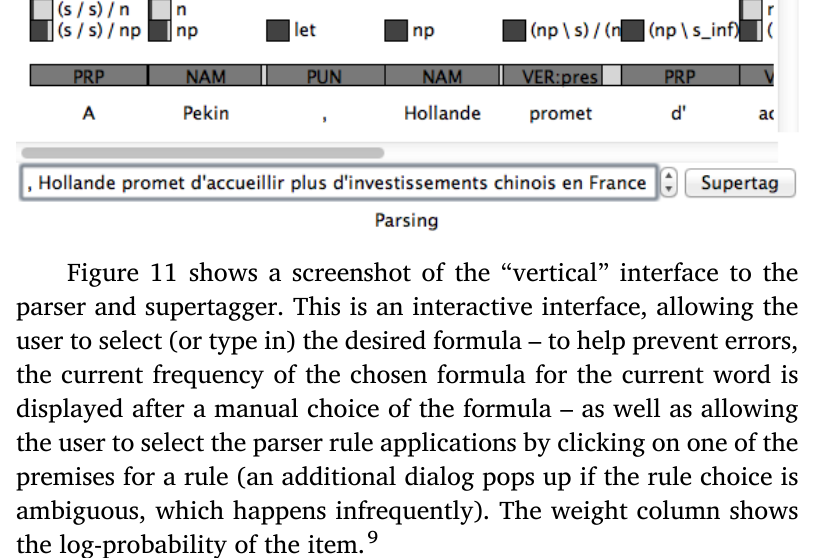
Figure 10: Screenshot of the supertagger